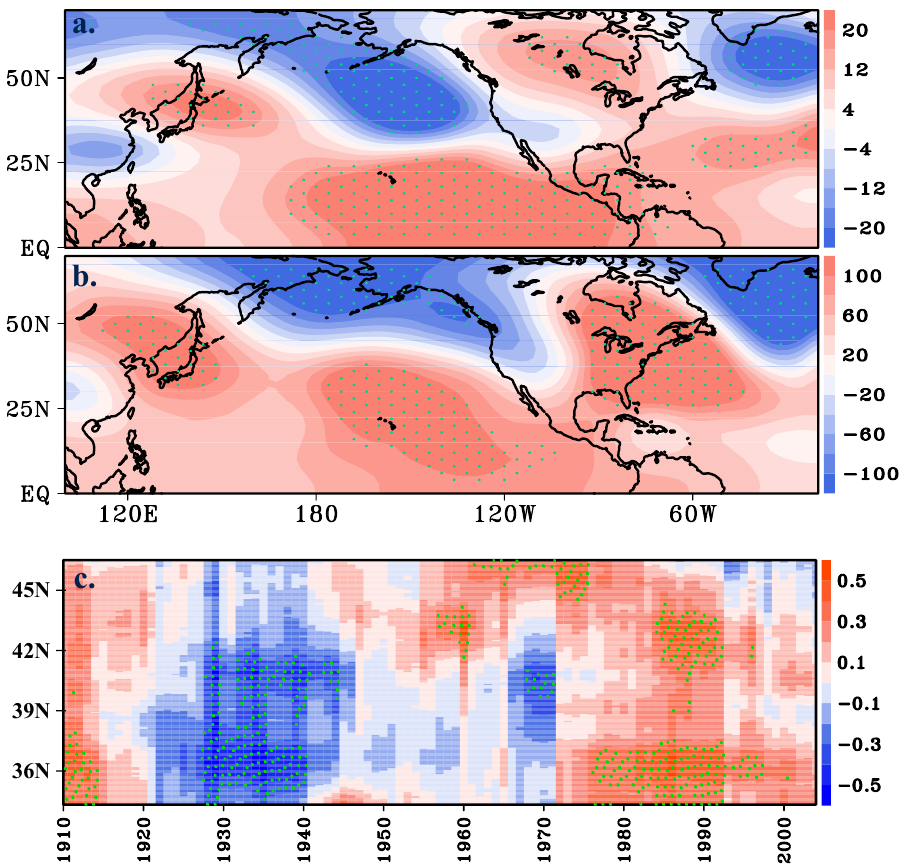
Figure 2. ( a ) Regression of 250-hPa height anomalies with Niño 3.4 in December, from 1950–2014; ( b ) December 2015 250 hPa height anomalies as a departure from the 1950–2010 base period; ( c ) Latitude-time plot of the 20-years sliding correlation between Nino 3.4 and December precipitation averaged over longitude 95° W–85° W. On the x-axis are the central years of the correlation window. Green stippling show significant areas at the 95% confidence level.